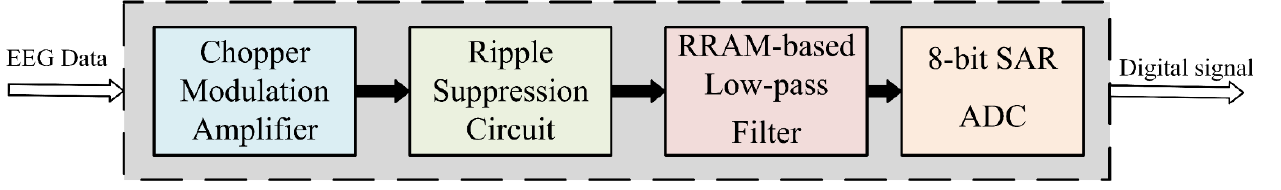
Figure 1. AFE diagram processing the EEG data input.